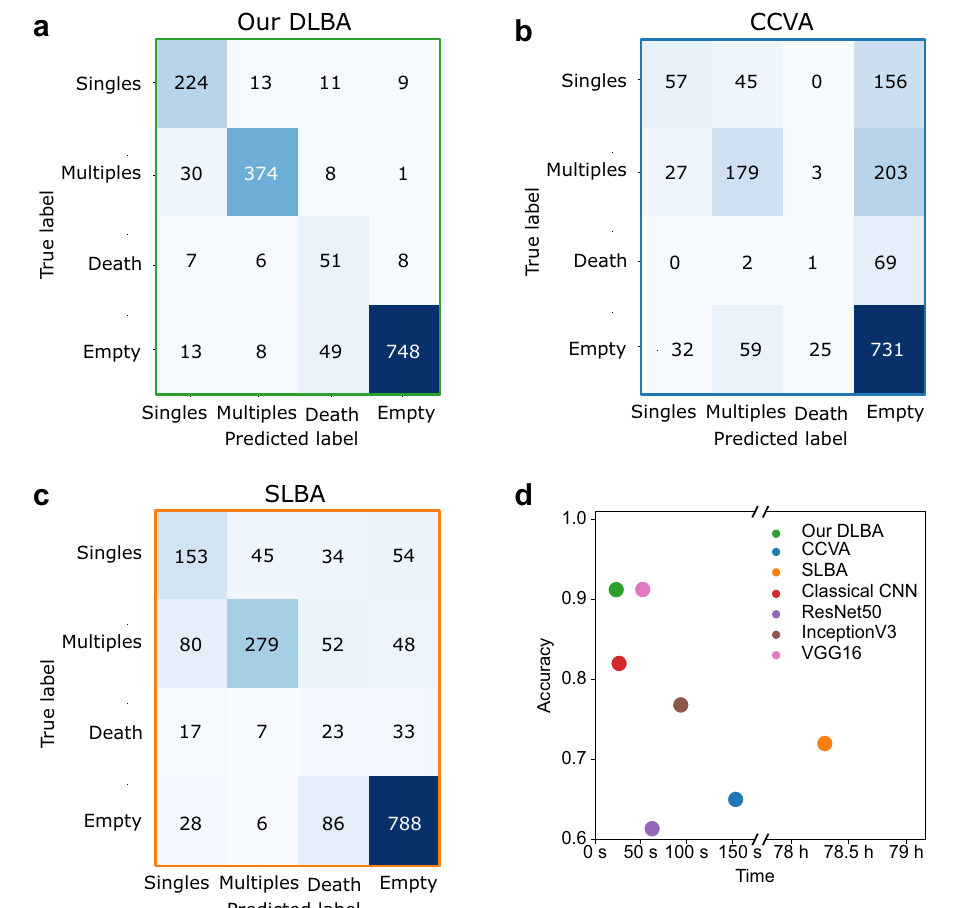
Figure 3. Global accuracy comparison between the different methods tested. ( a ) For our optimized DLBA: Double entry table analysing differences between the ground truth (“True label”, vertical axis) and the prediction (“Predicted label”, horizontal axis). Our optimized DLBA provided an accuracy of 91.2 ± 0.17% . Recall and precision were respectively 87% and 81% for “Singles”, 90% and 93% for “Multiple”, 70% and 42% for “Death”, and 91% and 97% for “Empty”. ( b ) The CCVA provided an accuracy of 65%. Recall and precision were respectively 22% and 66% for “Singles”, 42% and 62% for “Multiple”, 1% and 3% for “Death”, and 89% and 63% for “Empty”. ( c ) The SLBA provided an accuracy of 72%. Recall and precision were respectively 51% and 55% for “Singles”, 64% and 81% for “Multiple”, 22% and 10% for “Death”, and 88% and 85% for “Empty”. The color range stands for the amount of images in each category: the darker, the more images are associated. ( d ) Accuracy versus computation times for the 7 methods tested, for 1000 images See Table